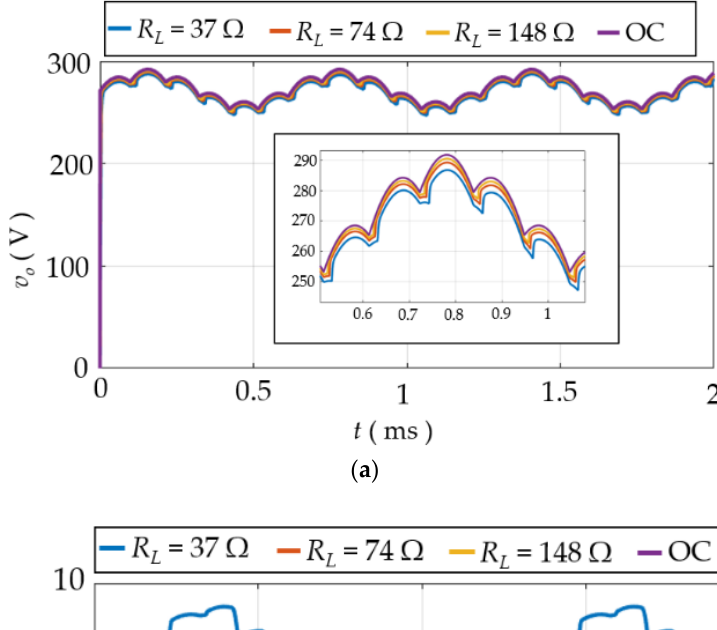
18 of 24 Figure 11. Typical input voltage waveforms under unbalanced operating conditions. 7.1. CTU under Unbalanced Input Voltage In Figure 12a, the output voltages v o computed under unbalanced voltage conditions for different loads are shown. The related output voltage ripples are indicated in Table 15. Table 15. CTU output voltage simulation results under unbalanced input voltage. Load